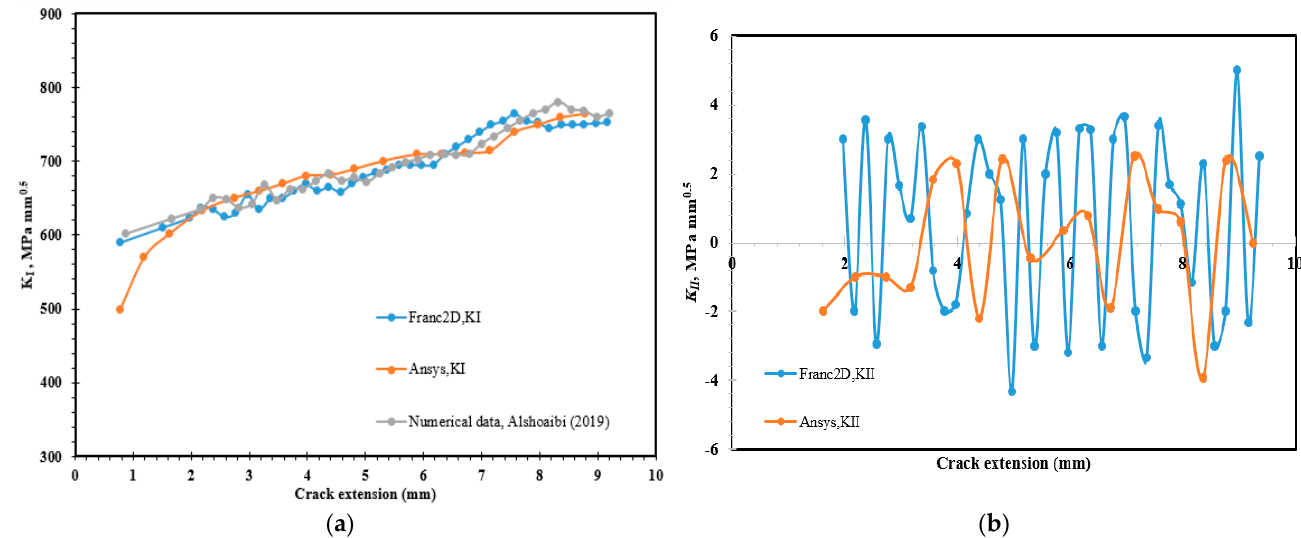
Figure 17. Stress intensity factors with corresponding crack length for specimen G7, ( a ) K I , and ( b ) K II . Table 3. Comparison for the fatigue life cycles for all